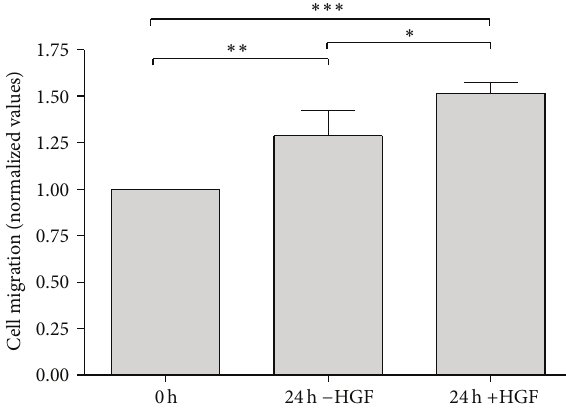
Figure 4: Analysis of HGF-dependent MSC migration after 24 hours in the presence and absence of HGF. Results based on 𝑛 = 4 . ∗ 𝑃 < 0.05 , ∗∗ 𝑃 < 0.01 , ∗∗∗ 𝑃 < 0.001